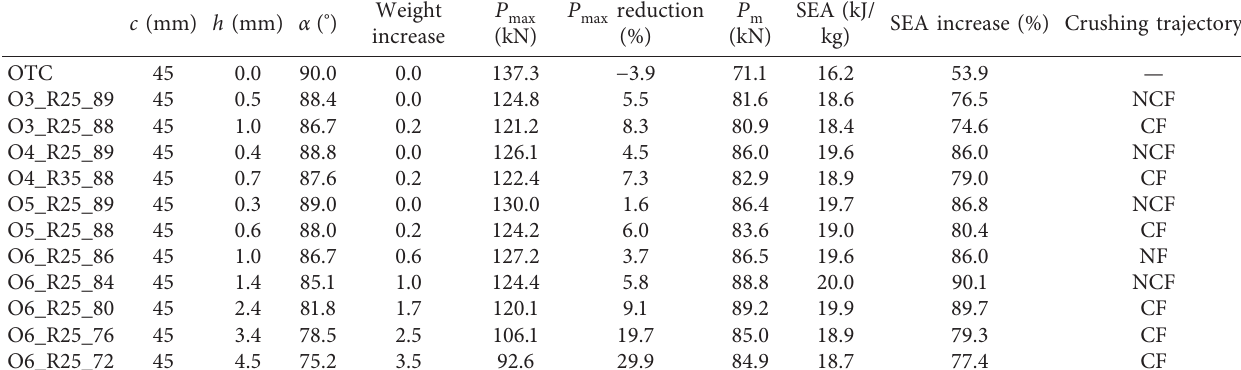
Table 4: Geometries and numerical results of traditional and prefolded octagonal tubes.